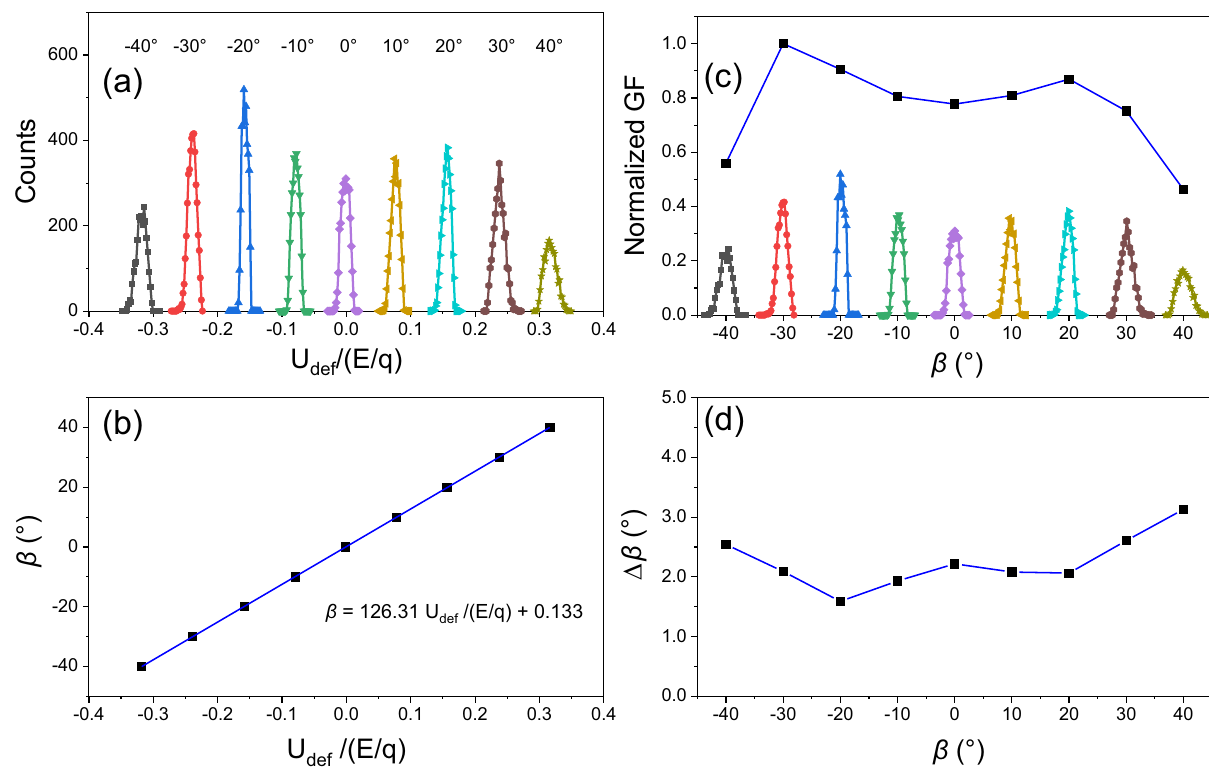
Figure 5: Simulation results for di ff erent elevation angles: ( a ) Elevation angular spectrum as the function of U def / ( E / q ) , ( b ) the linear relationship between the elevation angle β and U def / ( E / q ) , ( c ) the normalized GF for di ff erent elevation angles, and ( d ) the elevation angular